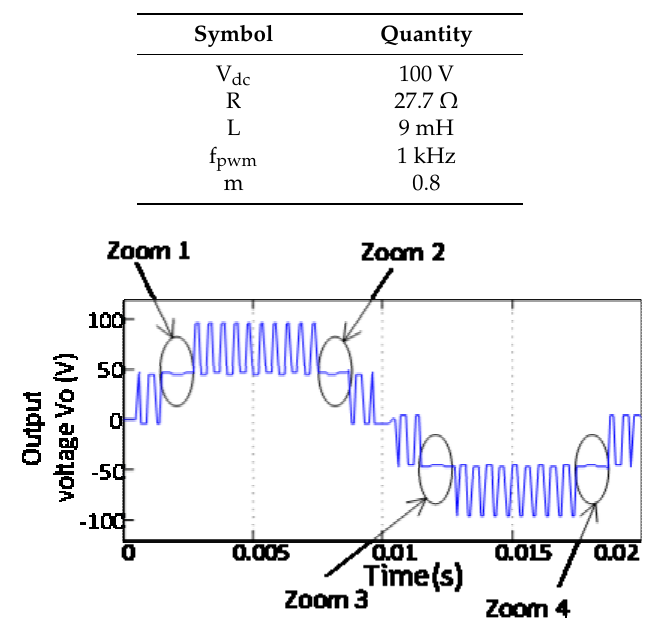
Table 1. Simulation parameters.